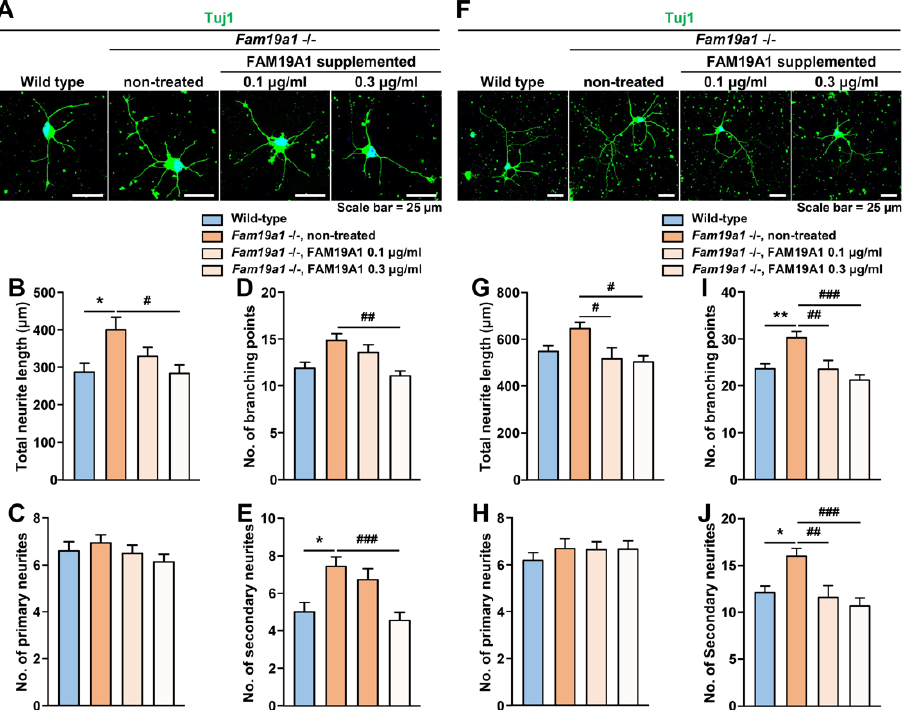
Figure 7. Morphological alterations in neurites of Fam19a1 − / − primary hippocampal neurons was reversed by His-tagged FAM19A1 supplementation. ( A – E ) Primary hippocampal neurons at days in vitro 3 (DIV 3). ( A ) Representative images of wild-type (WT) and Fam19a1 − / − neurons with or without his-tagged FAM19A1 supplementation. Neuronal morphologies were analyzed in terms of total neurite length; ( B ), total number of primary neurites; ( C ), total number of branching points; ( D ), and total number of secondary neurites; ( E ). ( F – J ) Primary hippocampal neurons at days in vitro 6 (DIV 6). ( F ) Representative images of WT and Fam19a1 − / − neurons with or without his-tagged FAM19A1 supplementation. Neuronal morphologies were analyzed in terms of total neurite length; ( G ), total number of primary neurites; ( H ), total number of branching points; ( I ), and total number of secondary neurites; ( J ). Experiments were performed in triplicate and at least 30 neurons were analyzed for each experimental group. Data are presented as means ± standard errors of means (SEM). * p < 0.05, ** p < 0.01 versus WT and # p < 0.05, ## p < 0.01, ### p < 0.001 versus non-treated Fam19a1 − / − by one-way analysis